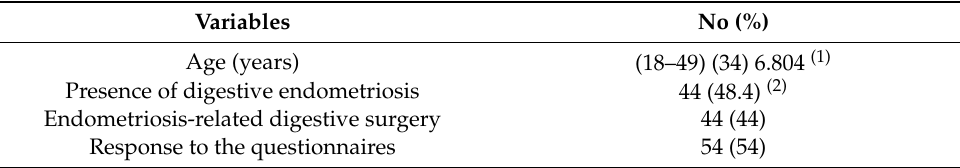
Table 1. Characteristics of the 100 patients meeting the inclusion criteria.